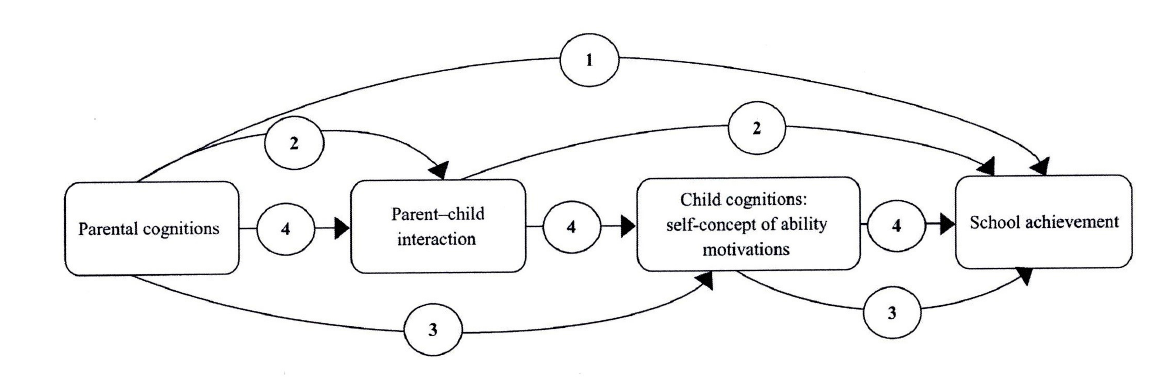
Figure 4. Some hypothesised direct and indirect influences of parental cognitions Parental cognitions are dynamic and can have various outcomes within the